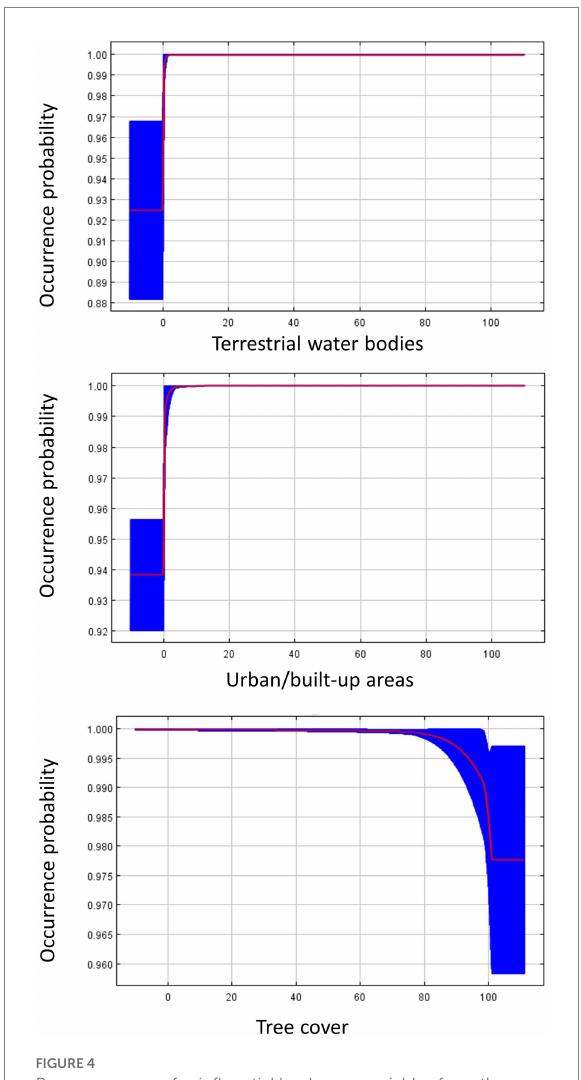
FIGURE 4 Response curves for influential land cover variables from the species distribution model predicting Dickcissel occurrence during fall migration. The response curves were generated in Maxent, and show how the predicted occurrence probability changes with each variable, while keeping all other variables at their average sample value. The red line plots the average value of the five model replicates, and the blue area plots the variance among the five